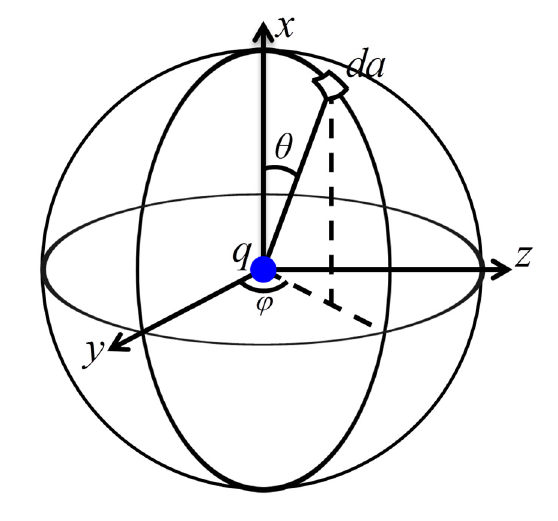
Figure 4. Coordinate system for the charged-shell charged-particle system. The particle (blue point) is positioned at the origin, which coincides with the center of the shell. The position of the area element (cid:1856)(cid:1853) of the shell is defined in terms of the angles θ and φ and the radius of the shell R. Gravity is in the negative (cid:1876)(cid:3548) direction. , is identical to the force on the charged particle, (cid:1832)(cid:1318) The force on the shell, (cid:1832)(cid:1318) (cid:3046)